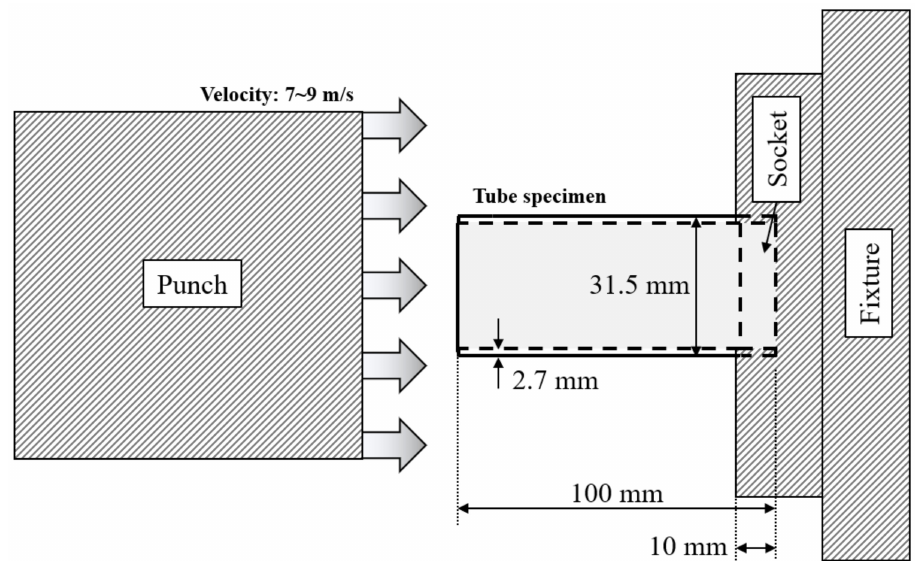
Figure 3. Schematic of dynamic crash test.